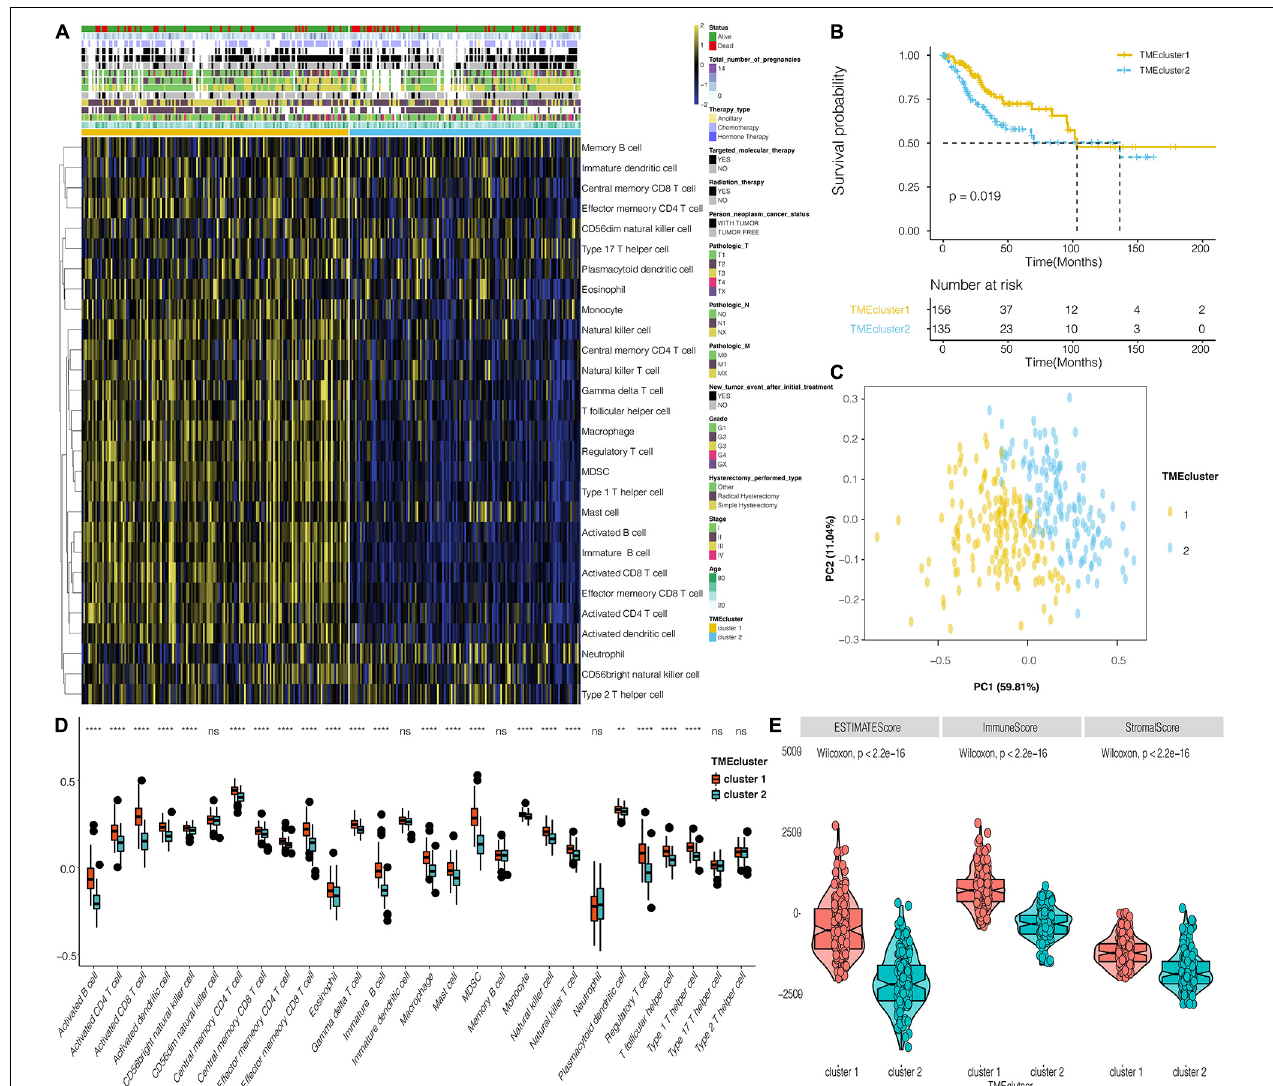
FIGURE 1 | The landscape of CESC TME, and the characteristics of TME subtypes in TCGA. (A) Unsupervised clustering of TME cells for 291 patients in TCGA. (B) Kaplan–Meier curves for 291 patients in TCGA, showing the association between TME infiltration patterns and OS (log-rank test, P < 0.001). (C) PCA for the two TME clusters. (D) The distribution of immunocytes in the two TME clusters. Within each group, the scattered dots represent values for cellular expression at TME whereas the thick line represents the median value. The bottom and top (lines) in the boxes are the 25th and 75th percentiles (interquartile range). The whiskers encompass 1.5 times the interquartile range. The statistical difference of the two TME clusters was compared using the Kruskal–Wallis test. **, P < 0.01; ****, P < 0.0001; ns, not statistically significant. (E) The differential expression of Estimate, Immune, and Stromal Score for TME clusters in the TCGA